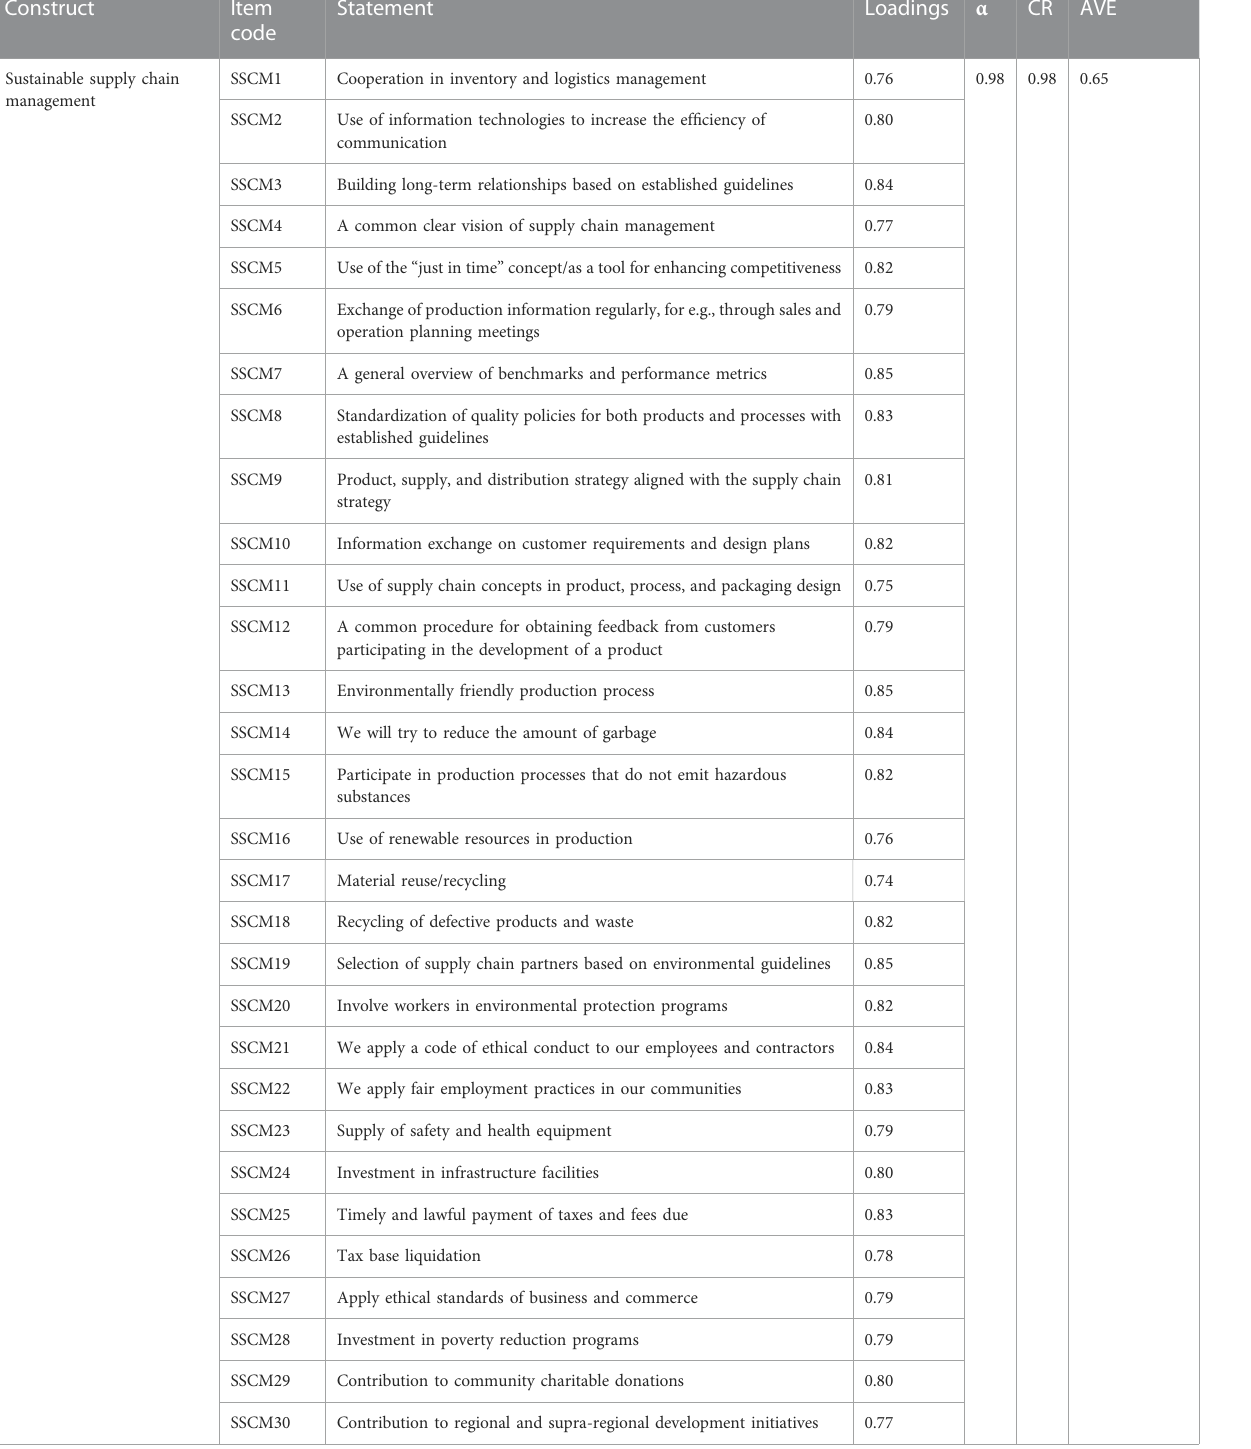
between the same constructs. Kline (2011) suggested a